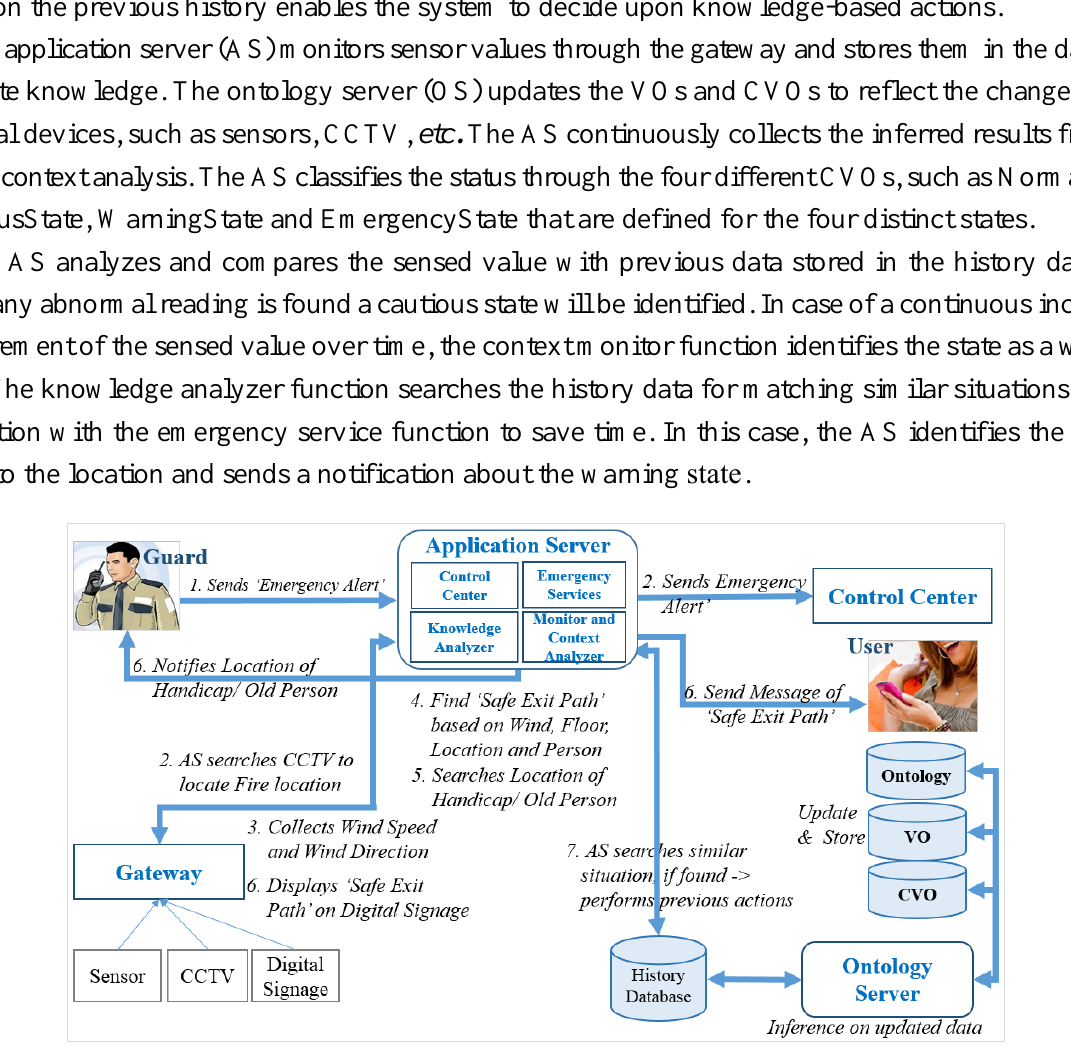
Figure 17. Flow diagram: notification of emergency state and the necessary actions taken by the AS to provide knowledge-based